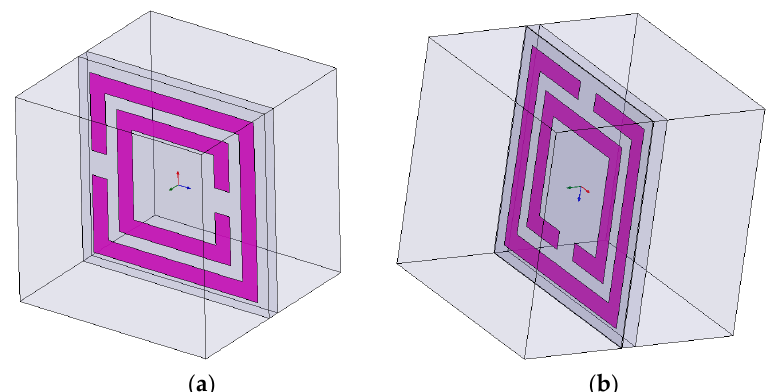
Figure 3. Simulation setup of ( a ) unit cell of the SRR. Two wave port excitation was placed on the left and right side to excite the SRR unit; ( b ) unit cell of SRR-Ferrite. A layer of ferrite film of 0.3 mm was placed on the top of the SRR surface. The ferrite film with a permittivity of 10 and permeability of 20 could increase the intrinsic inductance of the SRR unit cell.